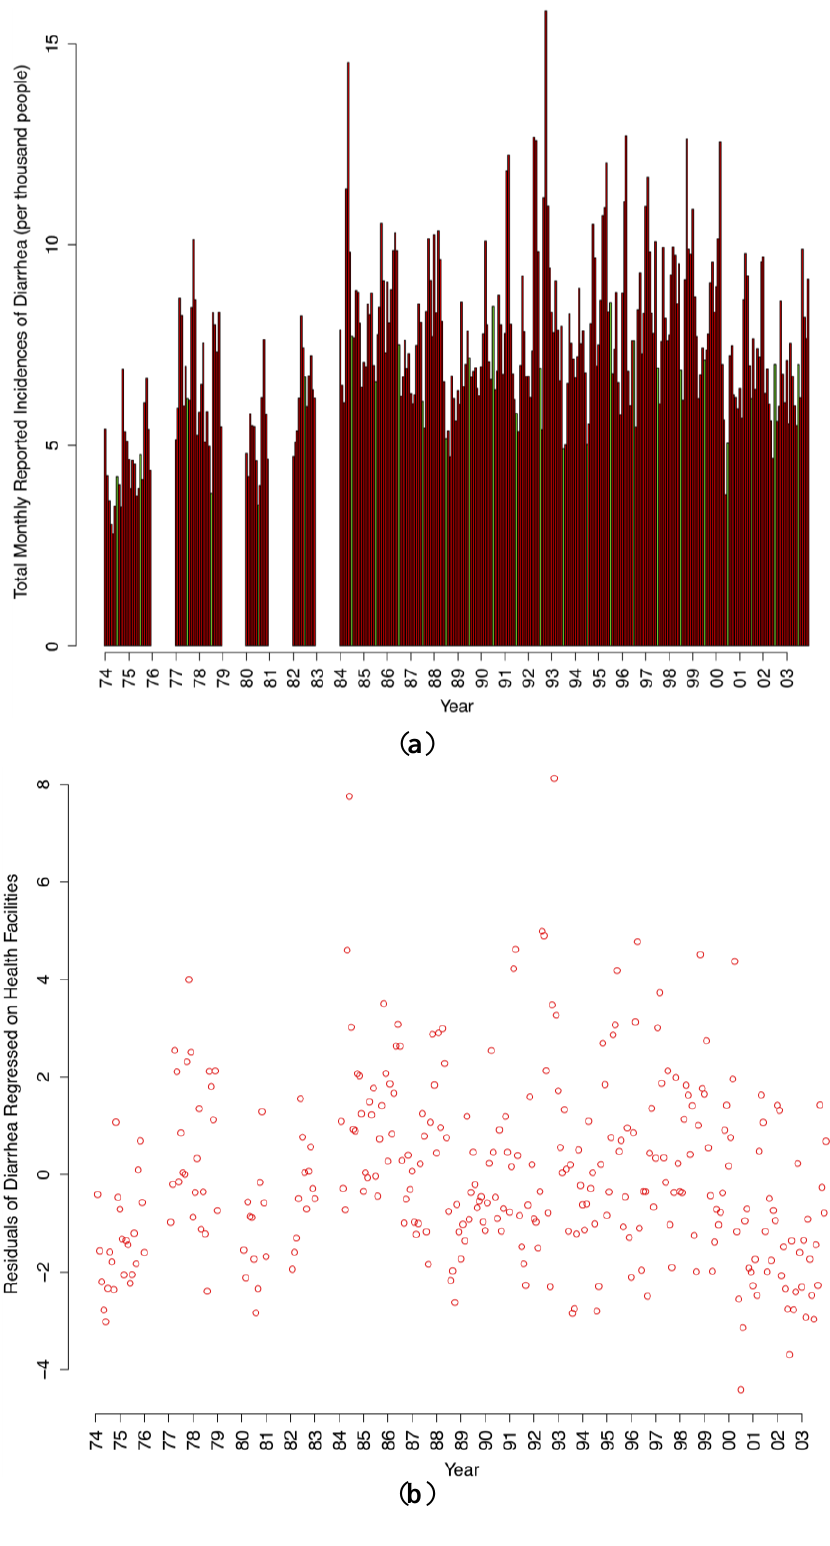
Figure 5. ( a ) Diarrheal case incidence among health facilities in Botswana from 1974–2003. Green bars indicate July, which occurs in the cold dry season. ( b ). Residuals of diarrheal case incidence are regressed against the number of health facilities developed over time providing a measure of variability in case incidence unaccounted for by growth in the number of health